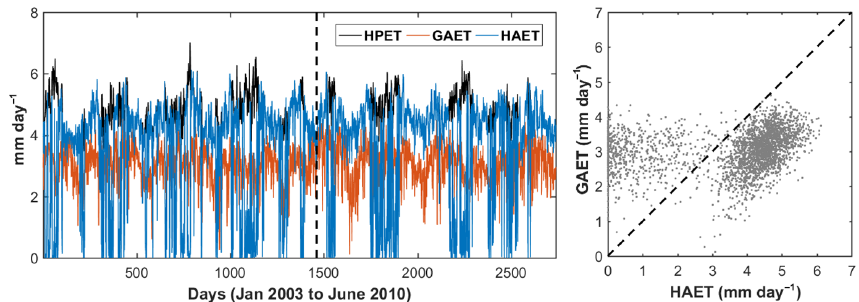
Figure 6. Time series and scatter plots of HPET, GAET, and HAET.